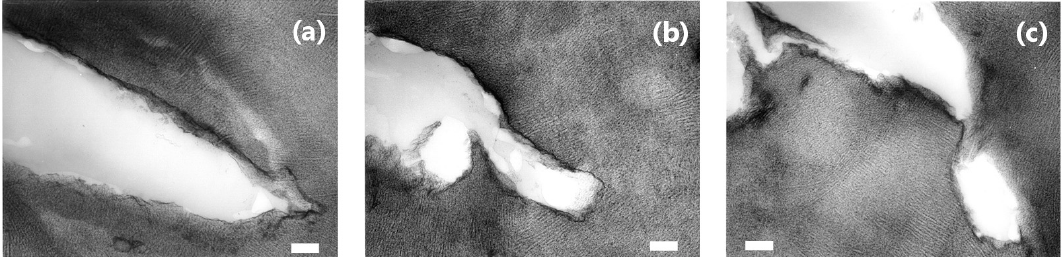
Figure 12. TEM images (osmium tetroxide stain) of ultrathin sections of MCC/MAPP/PP (22.5/2.5/75 w / w ) ternary composites with the following: ( a ) MAPP04, ( b ) MAPP12, and ( c ) MAPP20. Scale bars denote 100 nm. Reprinted from Ref. [33]. Copyright Elsevier Ltd. (2019).